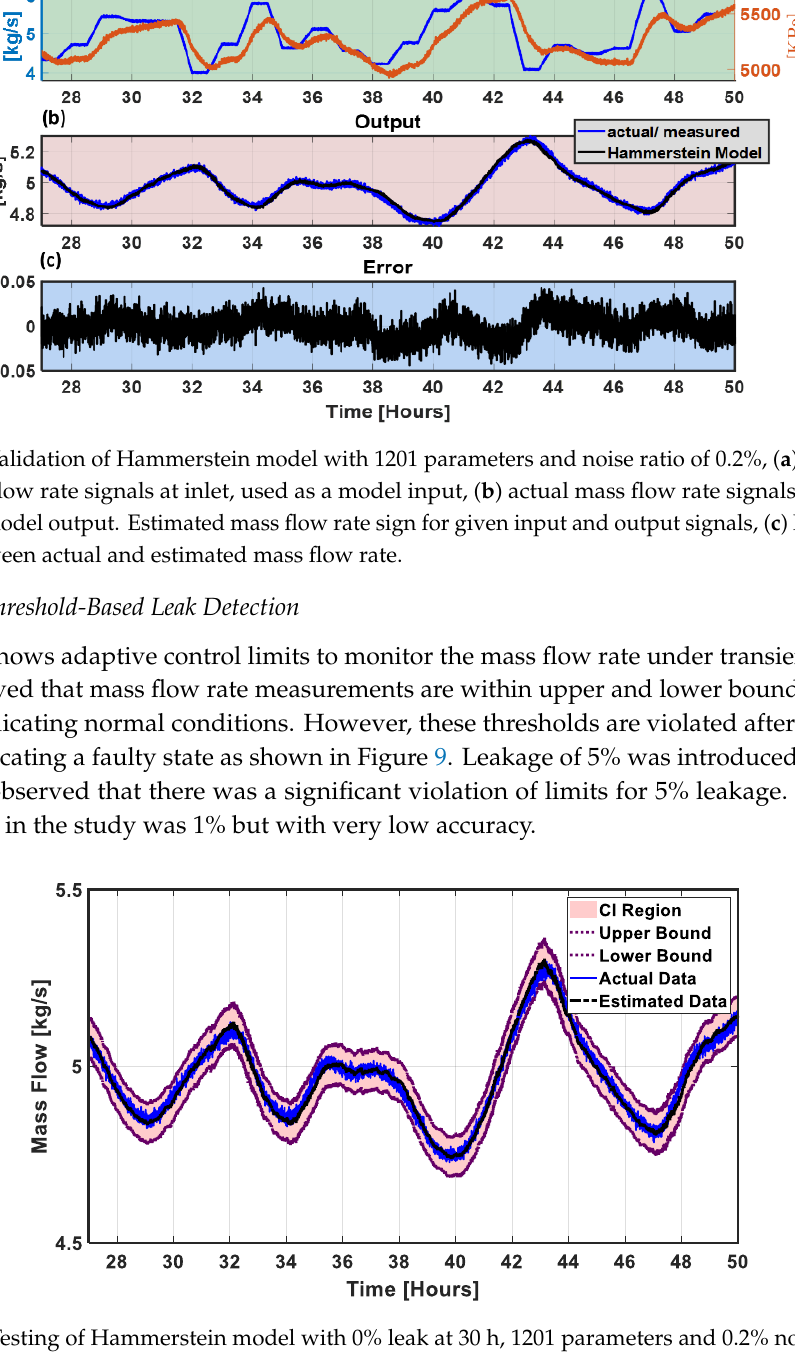
Figure 8. Testing of Hammerstein model with 0% leak at 30 h, 1201 parameters and 0.2% noise ratio.